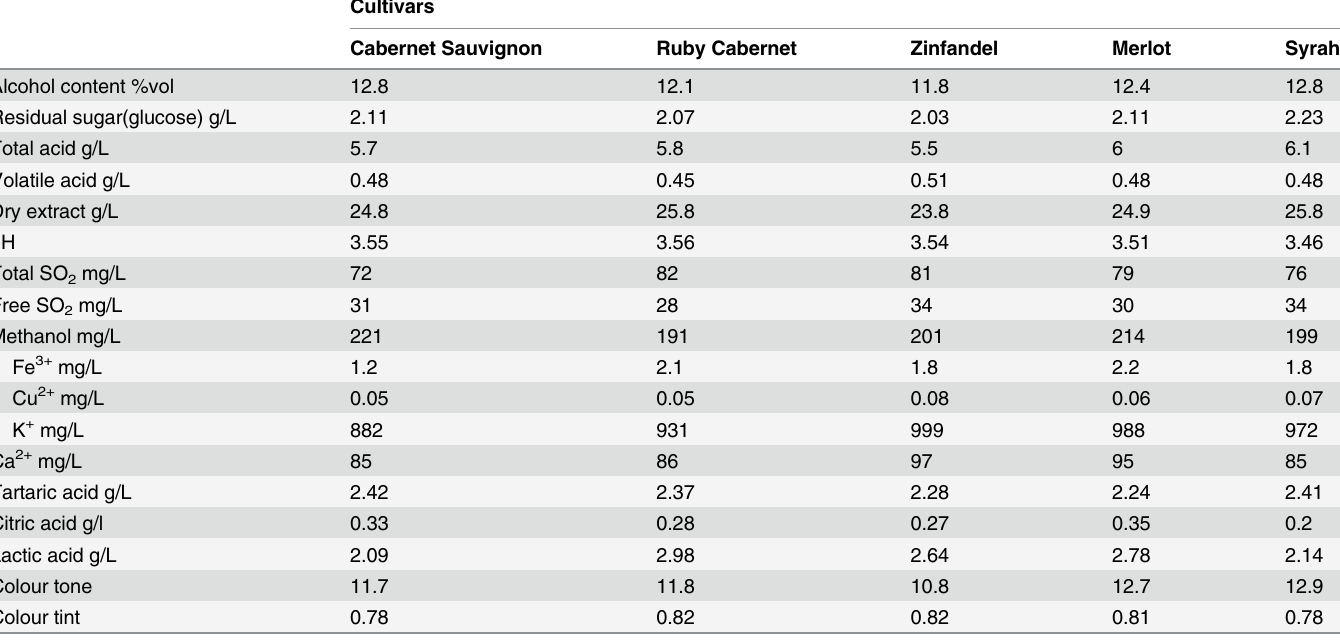
* Methods of determination of physical and chemical features accorded with China National Standard GB/T 15038 –